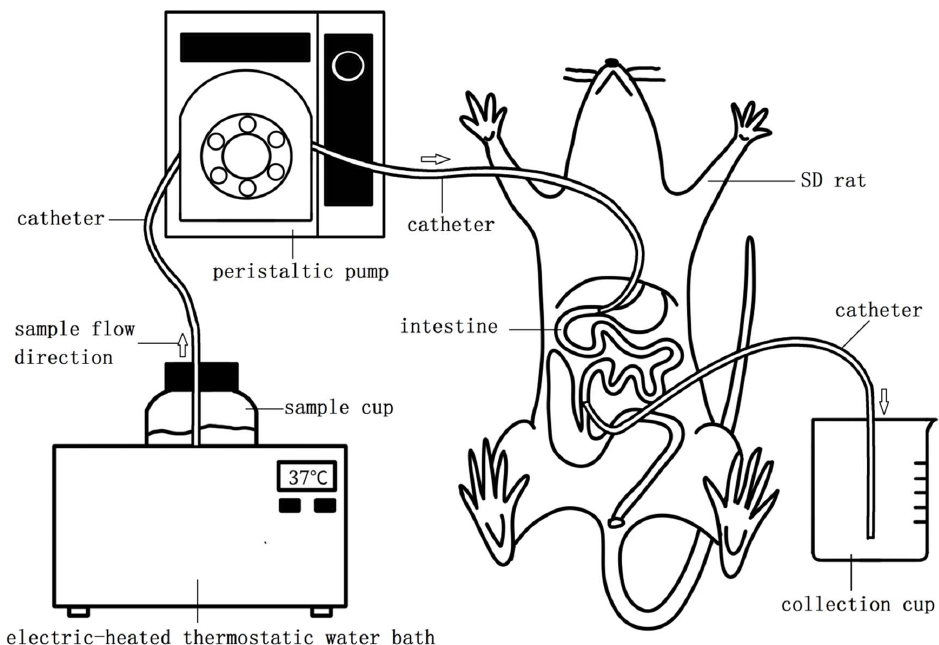
Figure 6. Schematic of the experimental SIM: 1-samle recipient; 2-peristaltic pump; 3-intestinal (from cardia of stomach to distal ileum); 4-SD rat; 5-recycling recipient; 6-sample flow direction; 7-catheter.